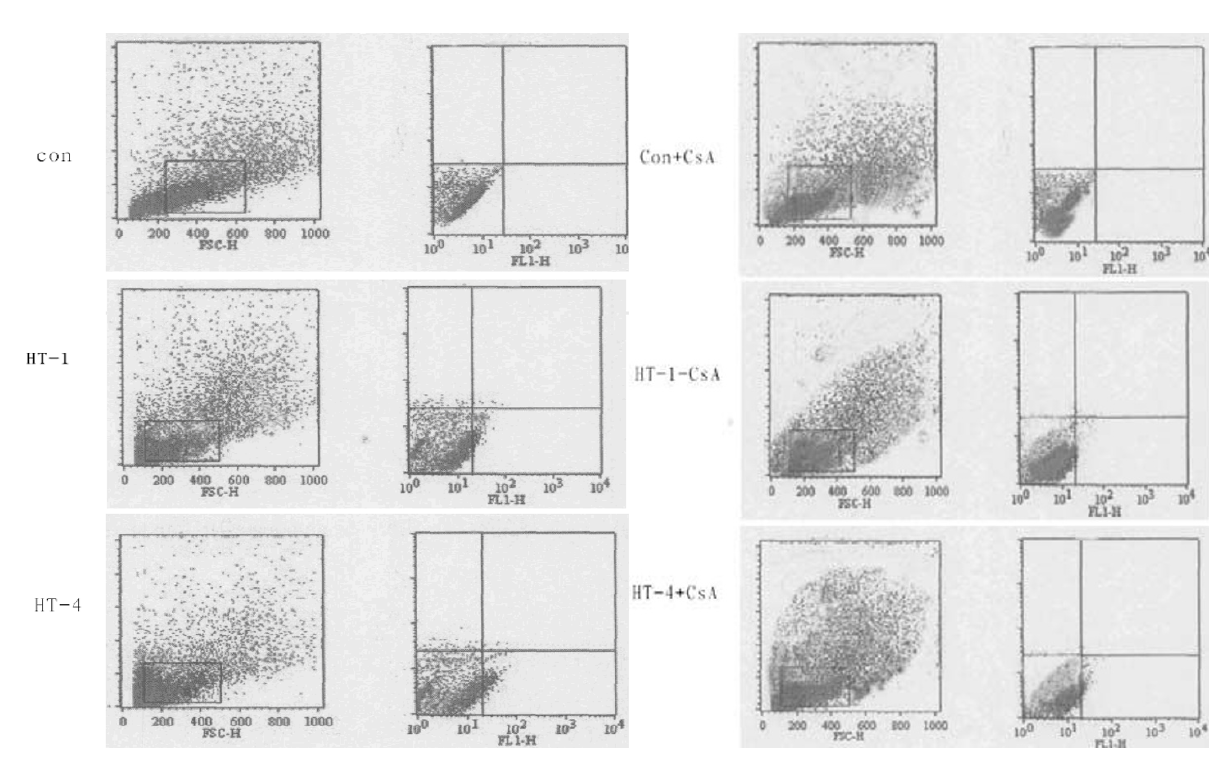
Figure 6 Apoptosis of cell lines from III-14, III-19, and controls . The left and right panels show flow cytometric analysis of apop- tosis before and after incubation with CsA (2 μ M) for 30 min,